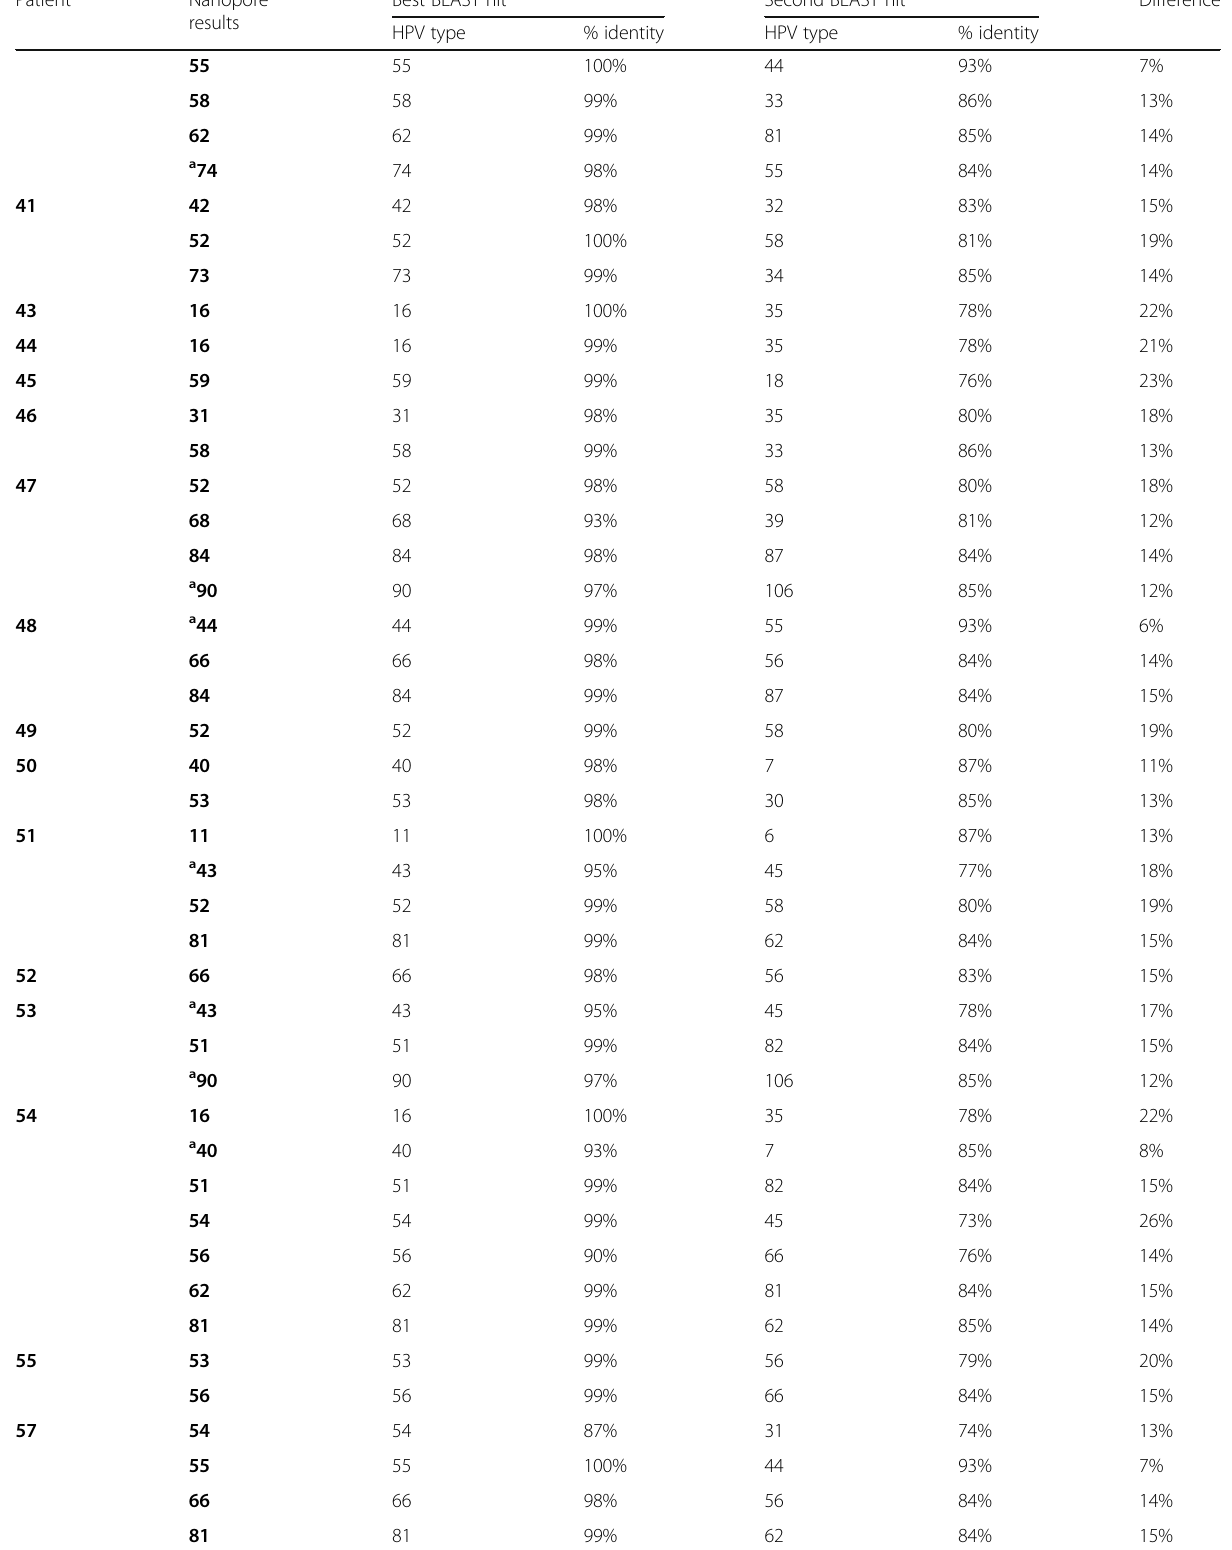
Table 7 Percentage of identity of Nanopore consensus sequences to HPV reference genomes (Continued)